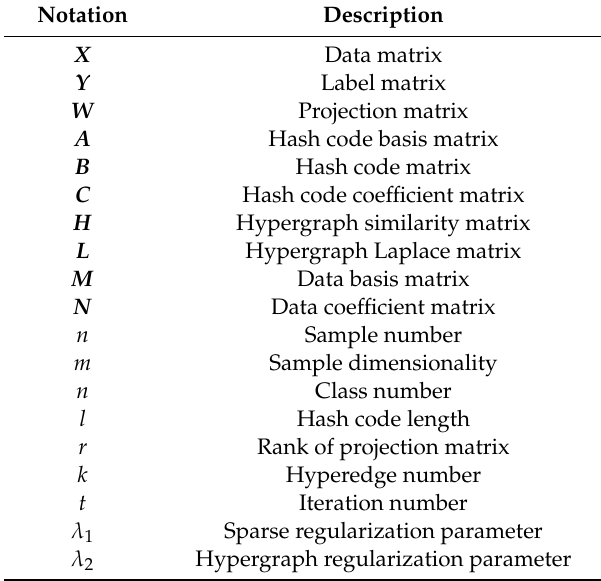
Table 1. Important notation used in this